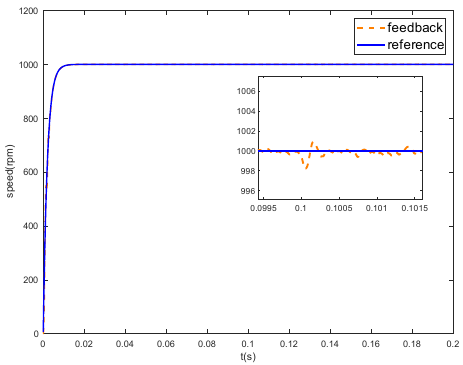
Figure 10. Speed response curve when α = 0.01.